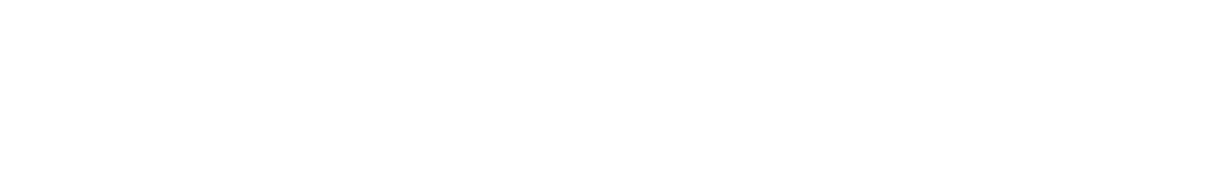
Frontiers in Genetics | Genetics of